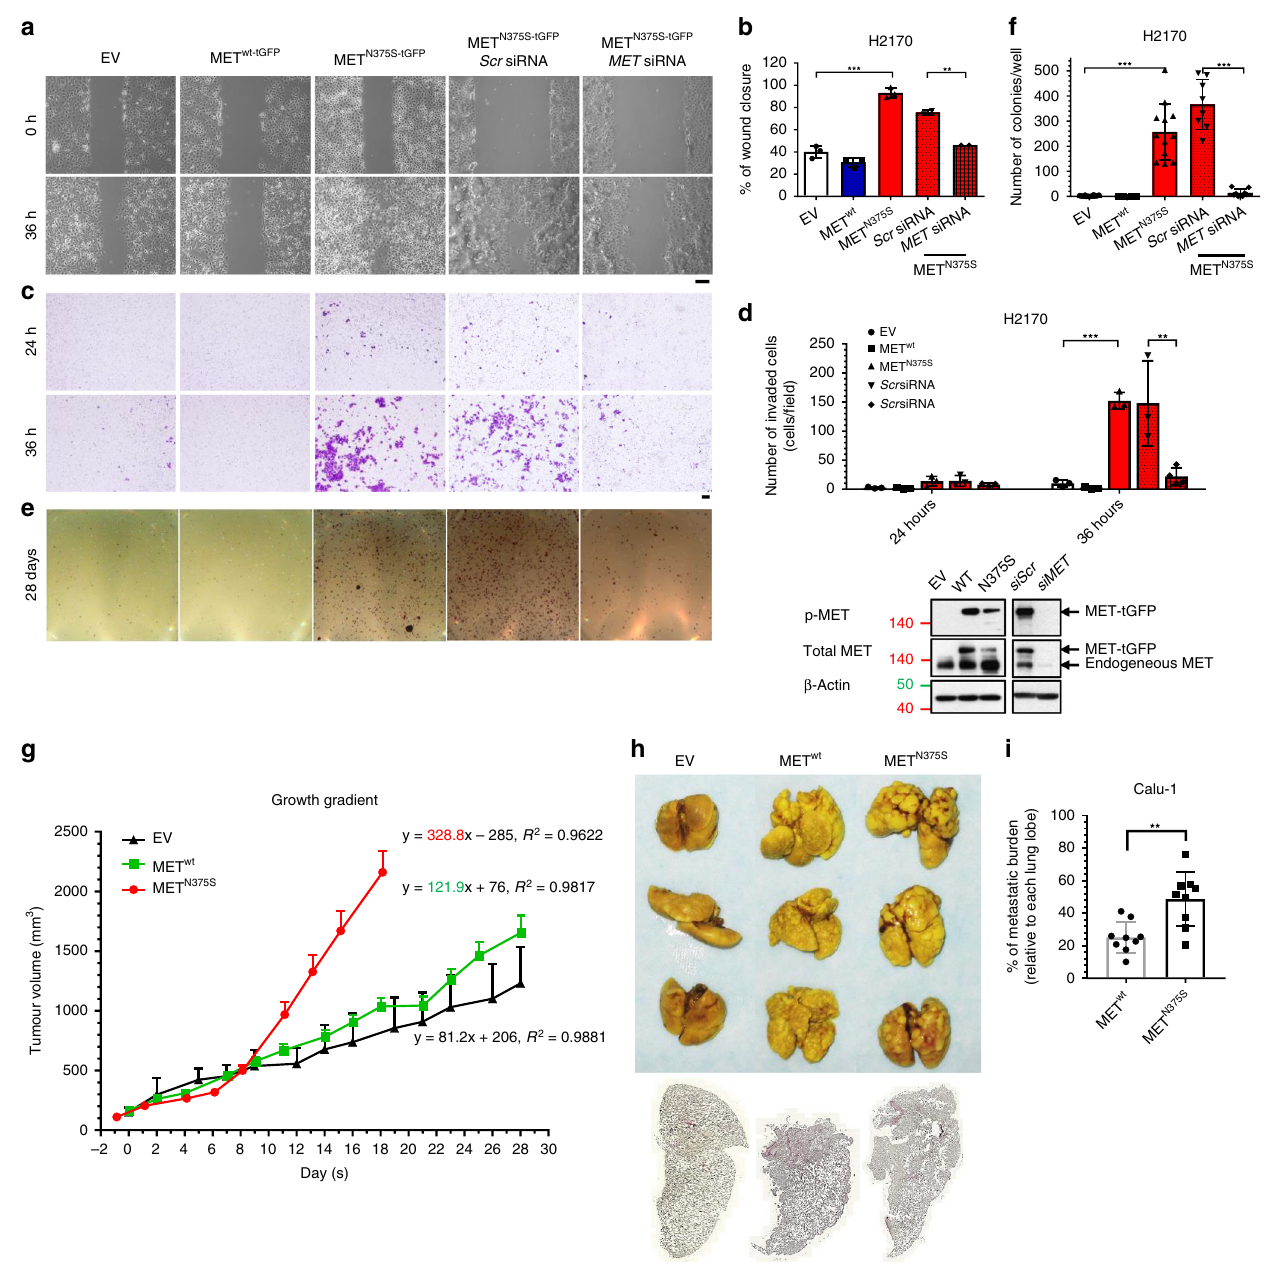
Fig. 2 MET N375S induces gain-of-function (GOF) phenotype in SCC cells. a – f Cell migration, invasion, and colony-forming assays were performed on isogenic H2170 empty vector (EV), wild-type (MET wt-tGFP ), and N375S mutant (MET N375S-tGFP ) clones with and without siRNA silencing. In total, 10 nM of scrambled ( Scr ) or MET siRNA was used per transfection. Immunoblots demonstrating expression levels of the total and phosphorylated MET are shown (bottom right). β -Actin was used as a loading control. a , b Wounded areas (eight fi elds/sample) were imaged at 0 h and 36 h after monolayer cultures were scratched. a Representative images are shown. Scale bar: 200 μ m. The wound-closure percentages for ( b ) EV, MET wt-tGFP and MET N375S-tGFP cells; Scr and MET siRNA transfected cells were quanti fi ed and expressed as mean ± SD ( n = 3). Two-tailed Student ’ s t test; * P < 0.05. c , d For invasion assay, cells seeded in Matrigel invasion chambers were fi xed and stained at 24 or 36 h, respectively. c Representative images are shown. Scale bar: 200 μ m. The number of cells in four random microscopic fi elds were quanti fi ed for EV, MET wt-tGFP , and MET N375S-tGFP cells; Scr and MET siRNA transfected cells ( d ), and expressed as mean ± SD in each fi eld ( n = 3). Two-tailed Student ’ s t test; * P < 0.05. e , f Representative images of colony formation for each cell types, stained with MTT at assay endpoint ( e ). The number of colonies were quanti fi ed for EV, MET wt-tGFP and MET N375S-tGFP H2170 cells; Scr and MET siRNA transfected cells ( f ) and expressed as mean of triplicates ± SD ( n = 3). Two-tailed Student ’ s t test; * P < 0.05. g Tumor growth of EV, MET wt-tGFP , and MET N375S-tGFP cells in xenografts with growth gradient displayed on the chart, presented as mean growth ± SEM ( n = 5). h – i Pulmonary metastases models were established with isogenic Calu-1 EV, MET wt-tGFP , and MET N375S-tGFP cells. h Macroscopic images of Bouin ’ s-stained lungs from three individual female mice per group, dosed by tail vein injection of the respective cells. White spots on the lungs are visible metastatic colonies. Below, representative stitched scanned images of H&E-stained paraf fi n-embedded lung cross section. i Metastatic tumor burden was quanti fi ed based on percentage of tumor area in respective lung tissues, three lung lobes per mice, presented as mean ± SD ( n =